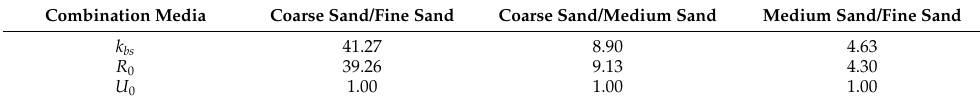
Table 4. Permeability contrast of three heterogeneous media combinations.